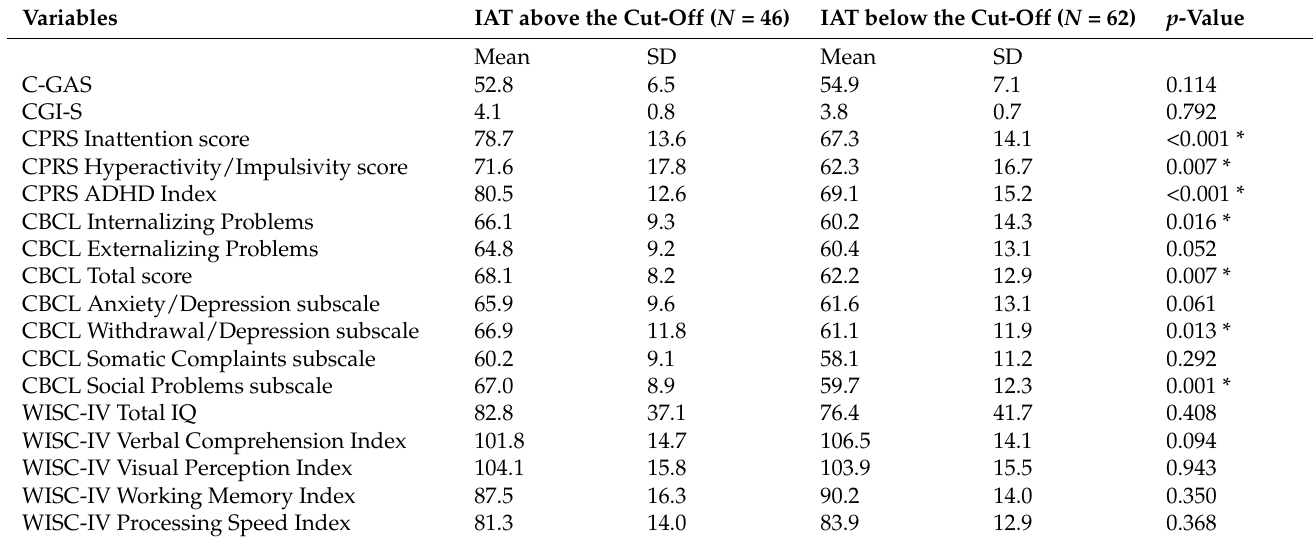
Table 1. Comparison between subjects scoring above and below the Internet Addiction Test (IAT) cut-off (means and standard deviations). Legend: IAT: Internet Addiction Test; C-GAS: Children’s Global Assessment Scale; CGI-S: Clinical Global Impression-Severity score; CPRS: Conners Parent Rating Scale; CBCL: Child Behavior Checklist; WISC-IV: Wechsler Intelligence Scale for Children—Fourth Edition. *: Statistical significance ( p < 0.05).